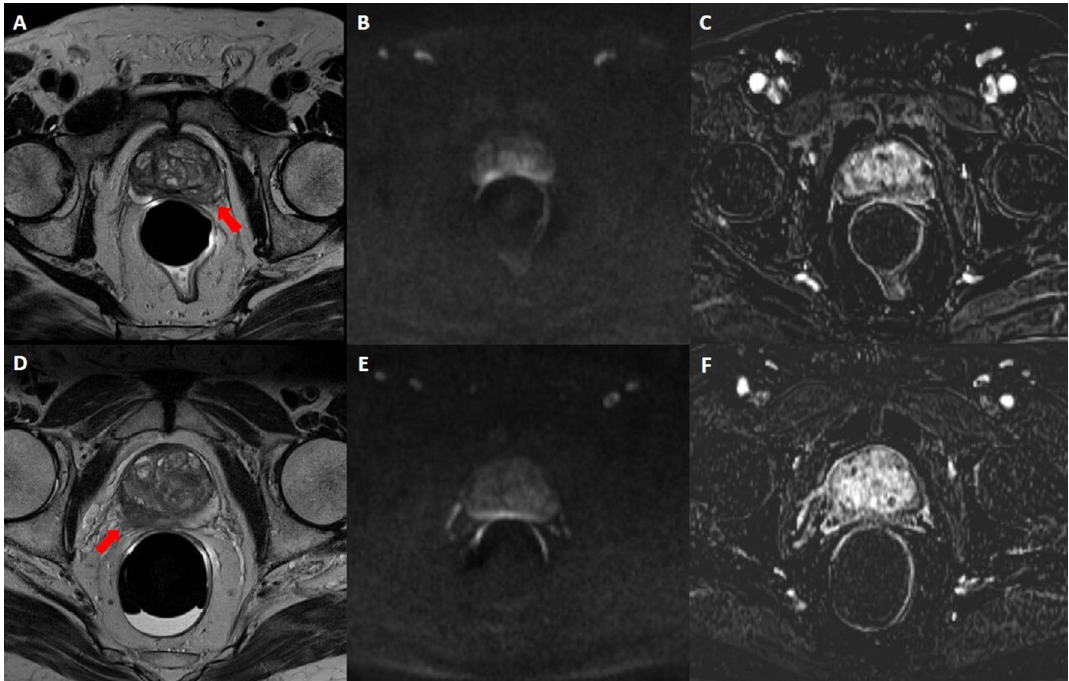
Figure 2. PI-RADS 3 scored alterations. In the first row, an example of PI-RADS 3 lesion confirmed at biopsy as GS 3 + 3: mpMRI showed reduced T2 signal intensity in the left PZ ( A ), altered diffusivity at b1000 DWI ( B ) without contrast enhancement ( C ). In the second row, an example of PI-RADS 3 lesion not confirmed at biopsy: mpMRI showed reduced T2 signal intensity in the right PZ ( D ), altered diffusivity at b1000 DWI ( E ) without contrast enhancement ( F ). PI-RADS prostate imaging-reporting and data system, mpMRI multiparametric MRI, DWI diffusion weighted MRI, PZ peripheral